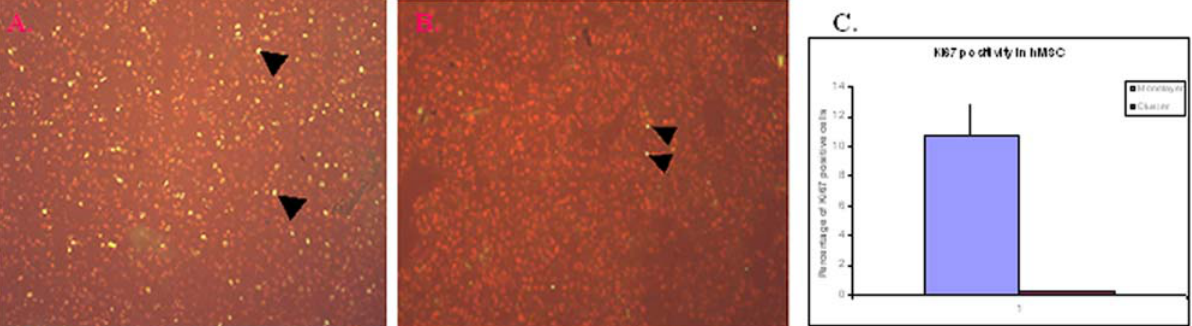
Figure 4. Analyses of the proliferation potential in hMSCs. Panel 4a shows the hMSC cells in monolayer culture, while the cluster cultured cells are shown in panel 4b. Panel 4c summarised the Ki67positive cells in both monolayer and cluster cultures. The yellow dots (the merged colour of green fluorescence and red propidium iodide) represent the Ki67positive cells. Some of the Ki67 positive cells are indicated with arrowhead. All experiments were repeated . 3